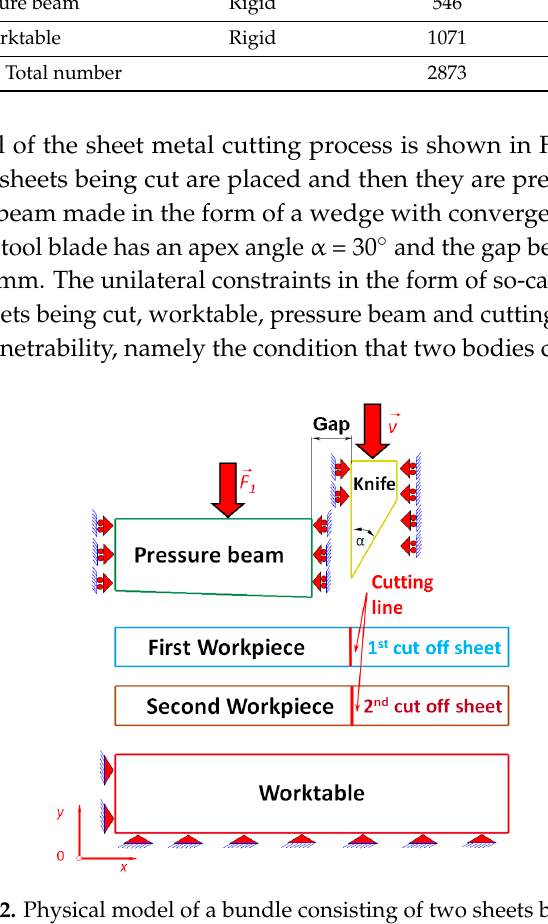
Table 2. Information about parts discretized into finite elements and nodes.